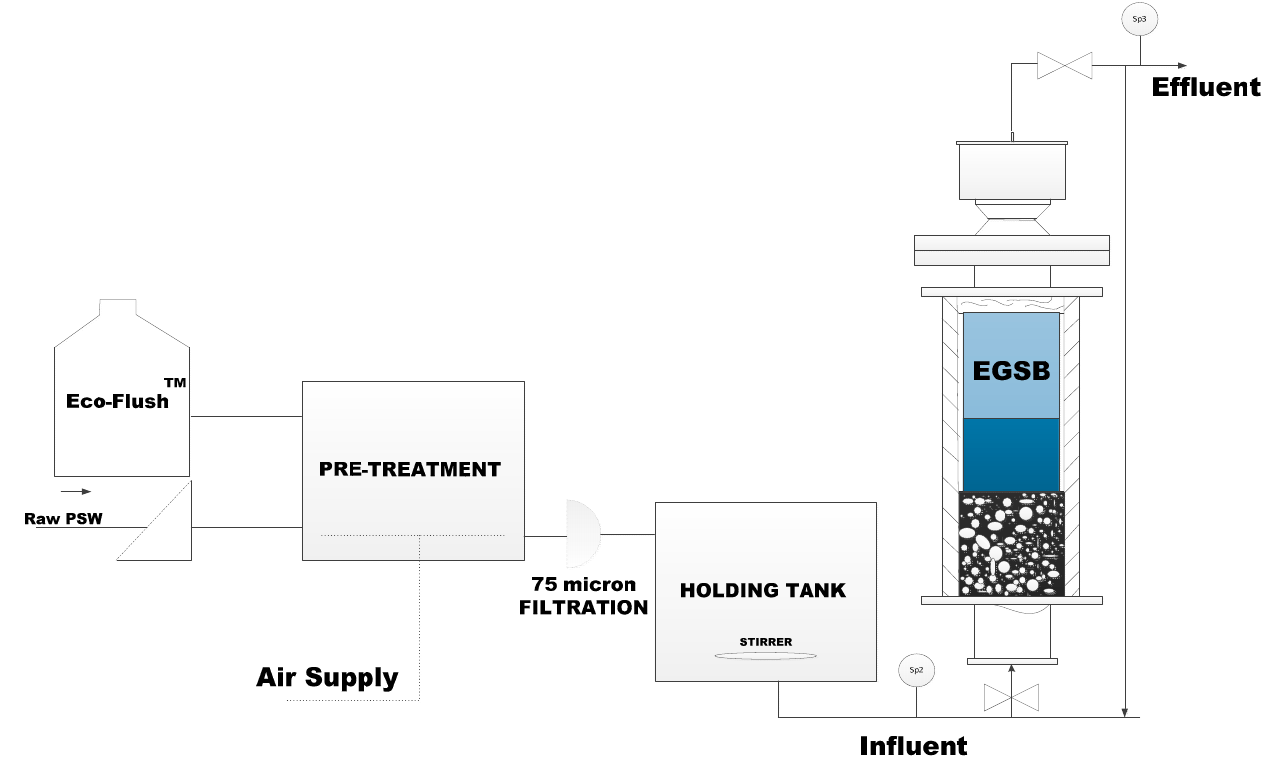
Figure 2. The EGSB reactor treatment process.